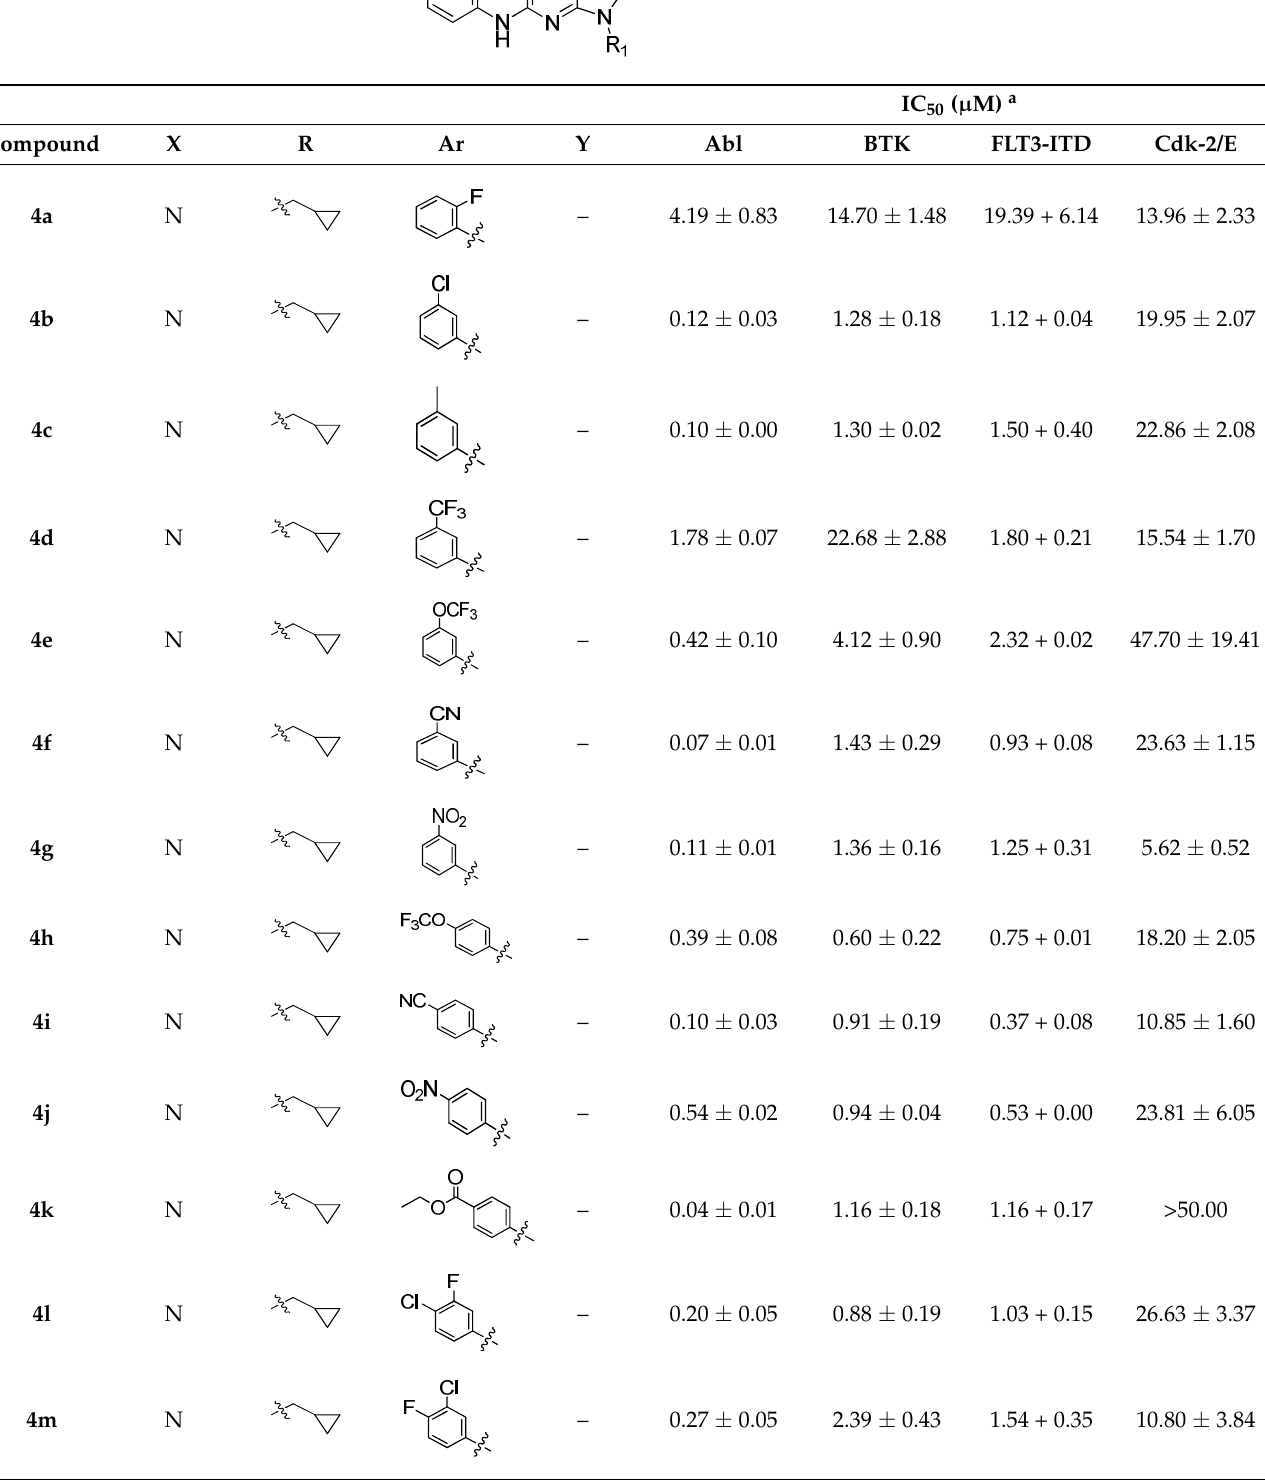
Table 1. In vitro inhibition of compounds 4a–o , 5a–l , 8a–c and 12 of the kinases Abl, BTK, FLT3-ITD and Cdk-2/Cyclin E.